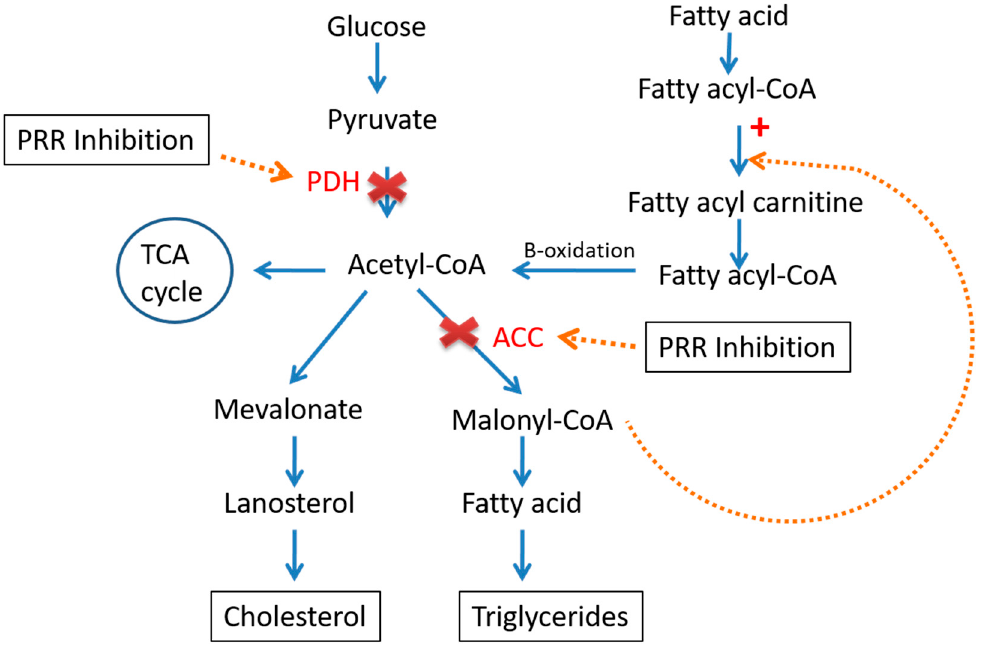
Figure 4. Role of pro-renin receptor (PRR) in glucose and lipid metabolism. Inhibition of PRR (N-acetyl-galactosamine PRR antisense oligonucleotide (G-PRR) used to inhibit PRR expression) decreases pyruvate dehydrogenase (PDH) and acetyl-CoA carboxylase (ACC), reduction in ACC in turn decreases the malonyl Co A that limits the FA synthesis.